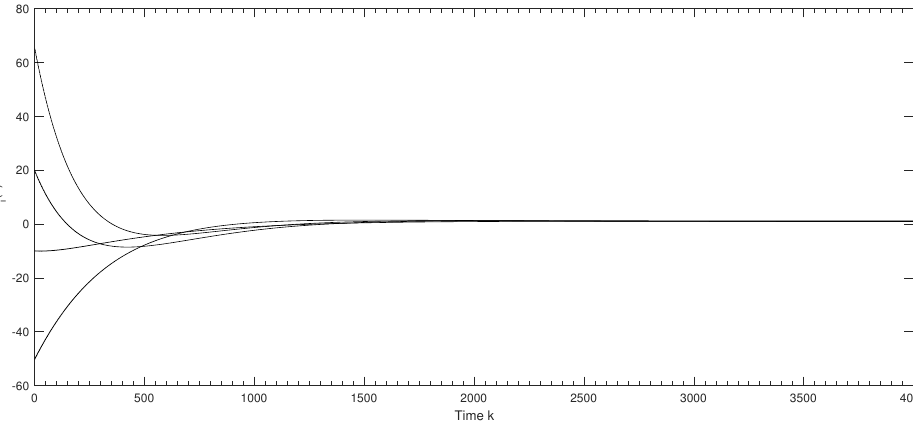
Figure 6. State trajectories of four agents in the case of switching topology and h =